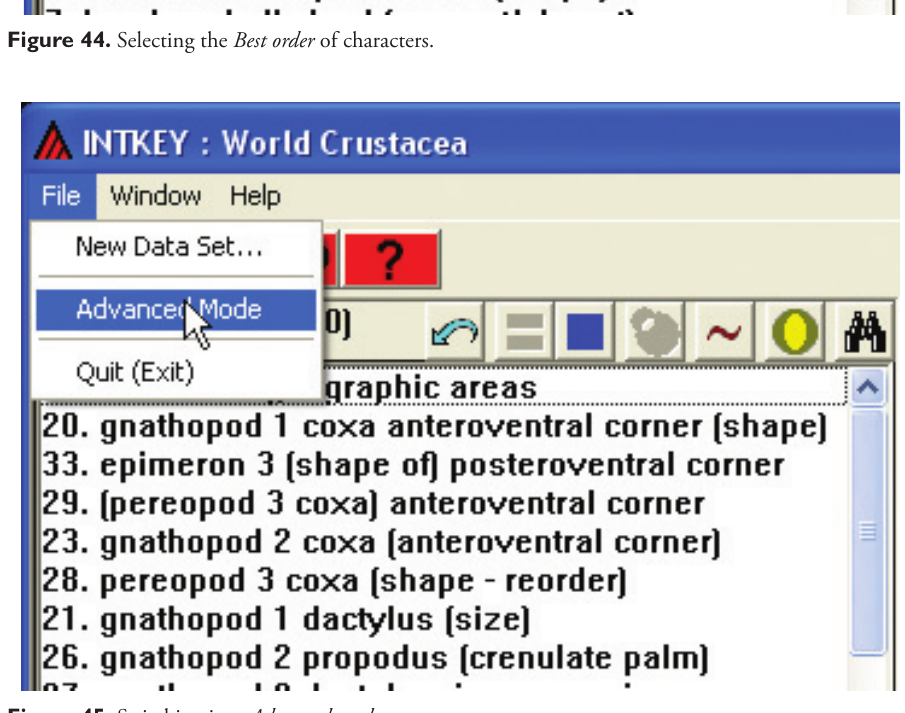
Figure 45. Switching into Advanced mode